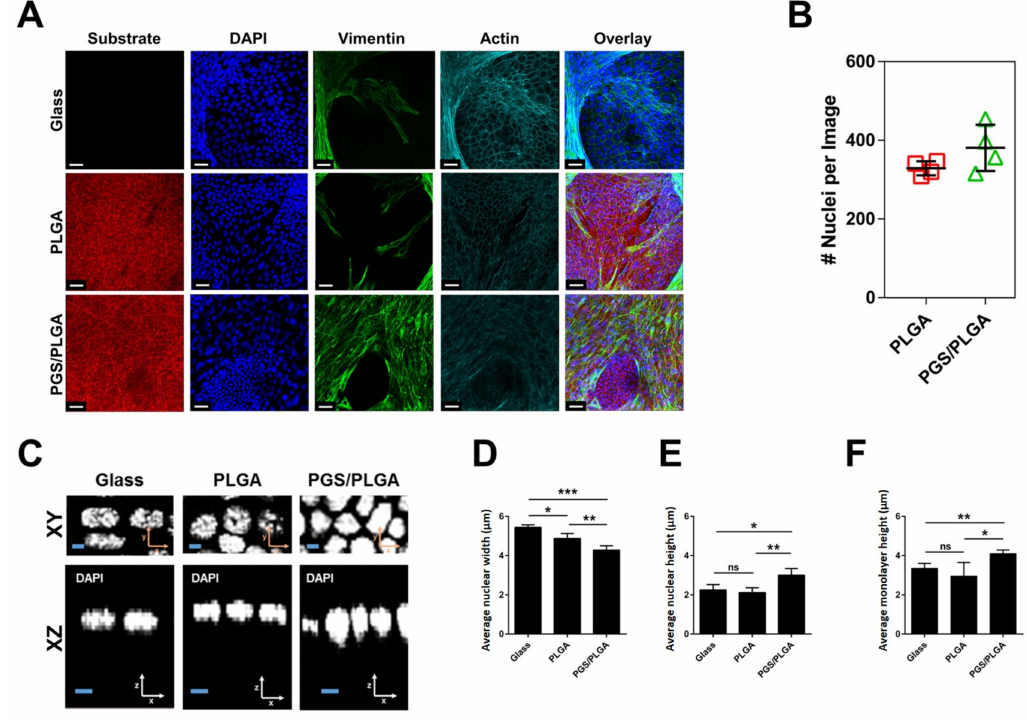
Figure 6. PGS/PLGA core/shell scaffolds promote enhanced epithelial self-organization. SIMS epithelial cells were grown in co-cultures with mesenchymal NIH 3T3 cells. ( A ) Maximum projection confocal images. Nanofibers (Red), nucleus (blue), actin cytoskeleton (cyan), and mesenchymal marker, vimentin (green). Scale, 30 µ m, ( B ) Quantification of cell counts for SIMS cells on PLGA and PGS/PLGA scaffolds from confocal images, ( C ) Single XY and XZ zoomed in images of SIMS cell nuclei stained with DAPI when co-cultured with 3T3 cells on the three substrates for 7 days. Scale bar, 2 µ m. Quantification of: ( D ) average nuclear widths, ( E ) average nuclear heights, ( F ) average monolayer heights with Bio-LIME cell. Data are means ± SD ( n = 4). NS: not significant, * p < 0.05, ** p < 0.01, *** p <